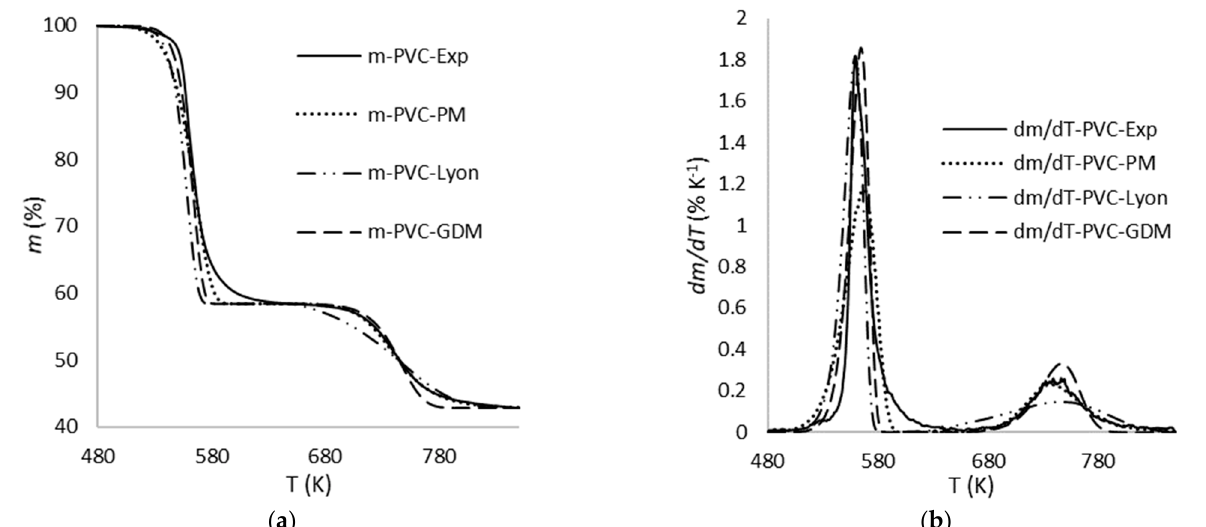
Figure 15. A comparison of experimental and calculated ( a ) mass and ( b ) dm / dT for PVC.